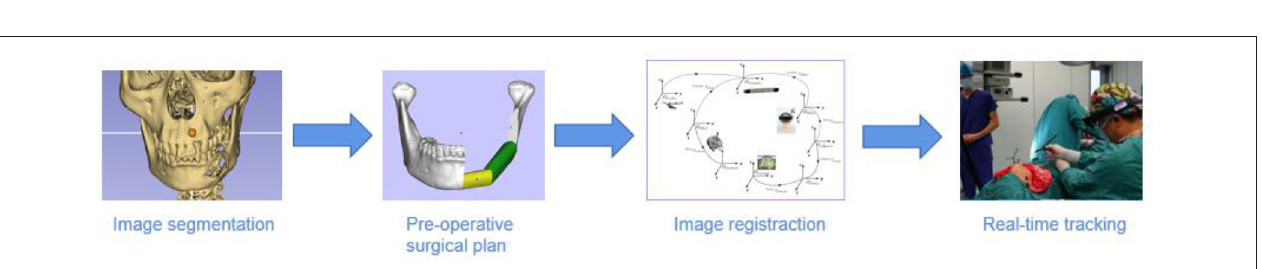
FIGURE 4 | The main procedures of MR-based surgical